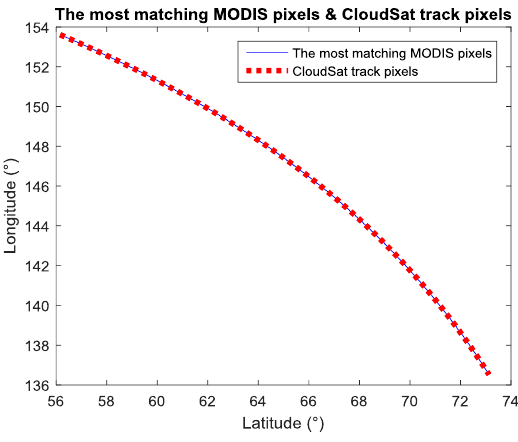
Figure 11. The most matching MODIS pixels and the CPR pixels on truncated track for the granule shown in Figure 7 using Equation (2) [38].